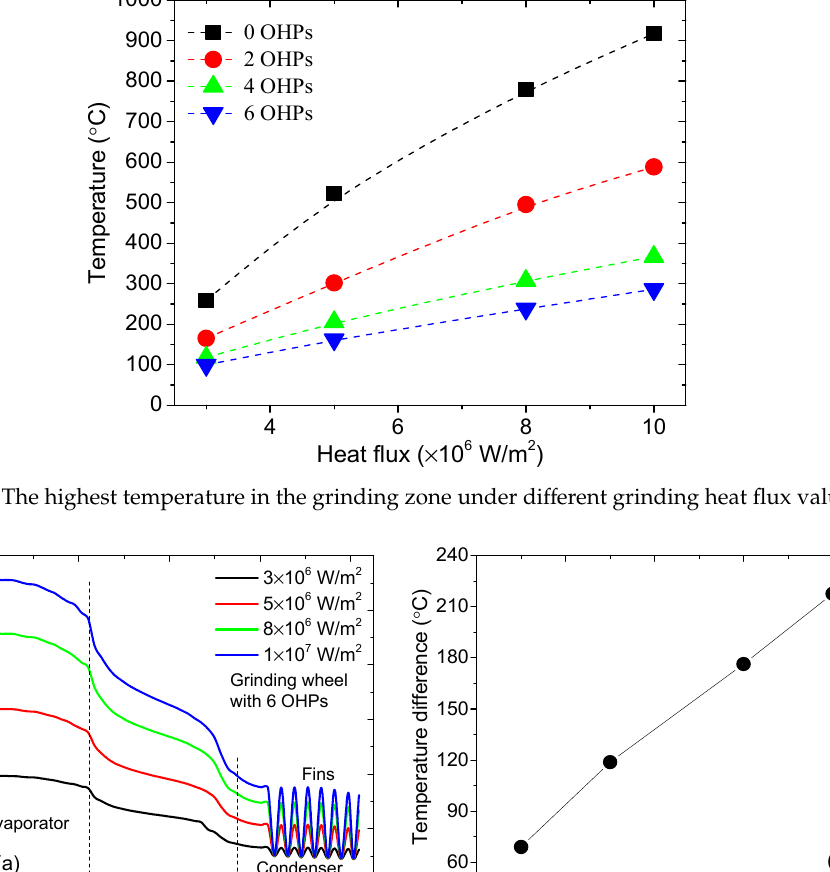
Figure 7. Temperature of the grinding wheel under different heat flux values ( a ) along the axial direction, and ( b ) the temperature difference between the evaporator and condenser.